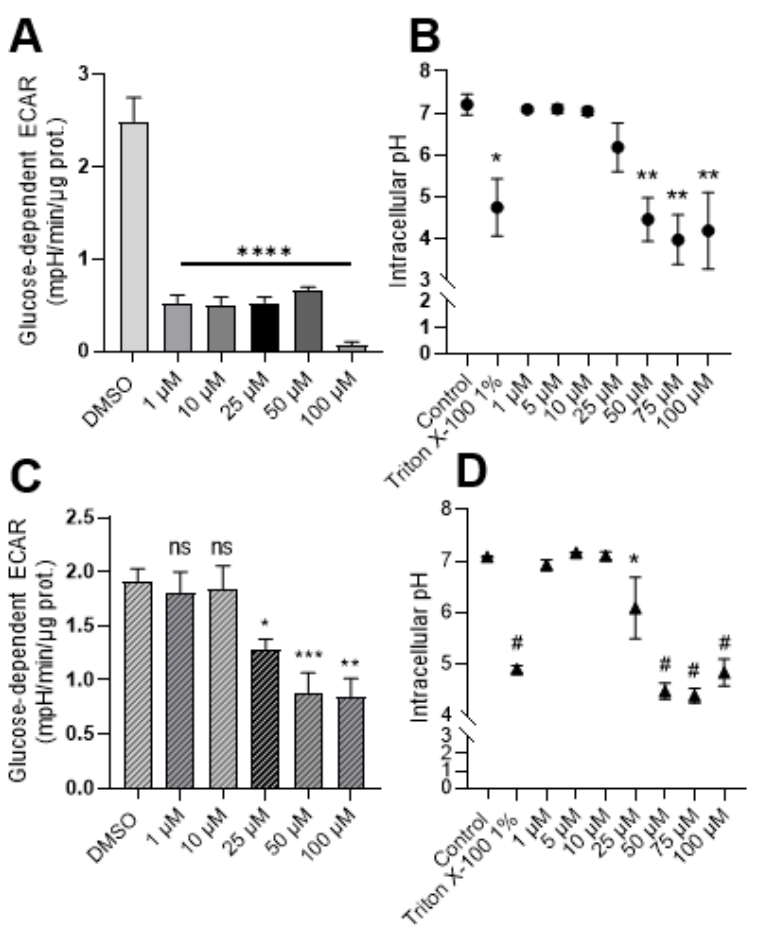
Figure 2. Syrosingopine reduces the extracellular acidification rate (ECAR) and decreases intracellular pH in cancer cells. Glucose-dependent ECAR was determined using the Seahorse XF96 bioenergetic analyzer in MDA-MB-231 ( A ) and FaDu cells ( C ) after 24 h of treatment with increasing concentrations of syrosingopine. Intracellular pH values were measured in MDA-MB-231 ( B ) and FaDu cells ( D ) after 72 h of treatment with increasing concentrations of syrosingopine. Data are represented as mean ± SEM of at least three independent experiments. Significance was determined using one-way or two-way ANOVA: * p < 0.05; ** p < 0.01; *** p < 0.001; # = **** p < 0.0001. ns = not